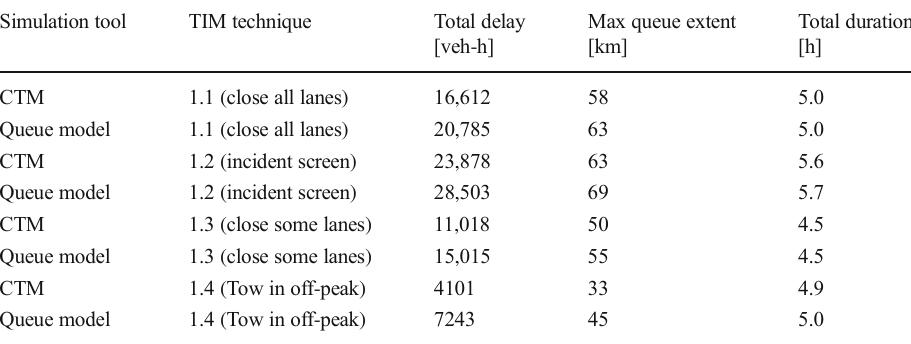
Table 8 Comparing incident estimations simulated by CTM-v and queue model for Scenario 1 (Collision), comparing only congested locations upstream of the incident